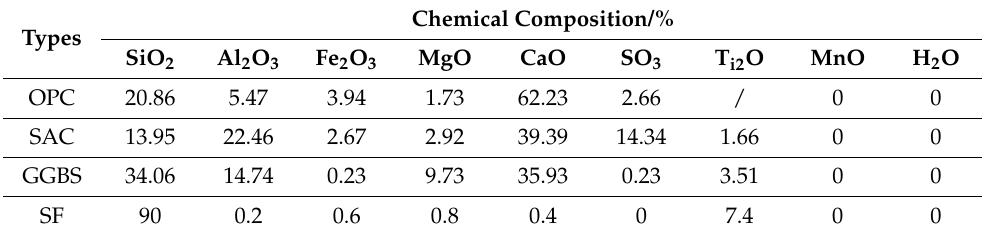
Table 2. Chemical composition of cementitious materials/%.